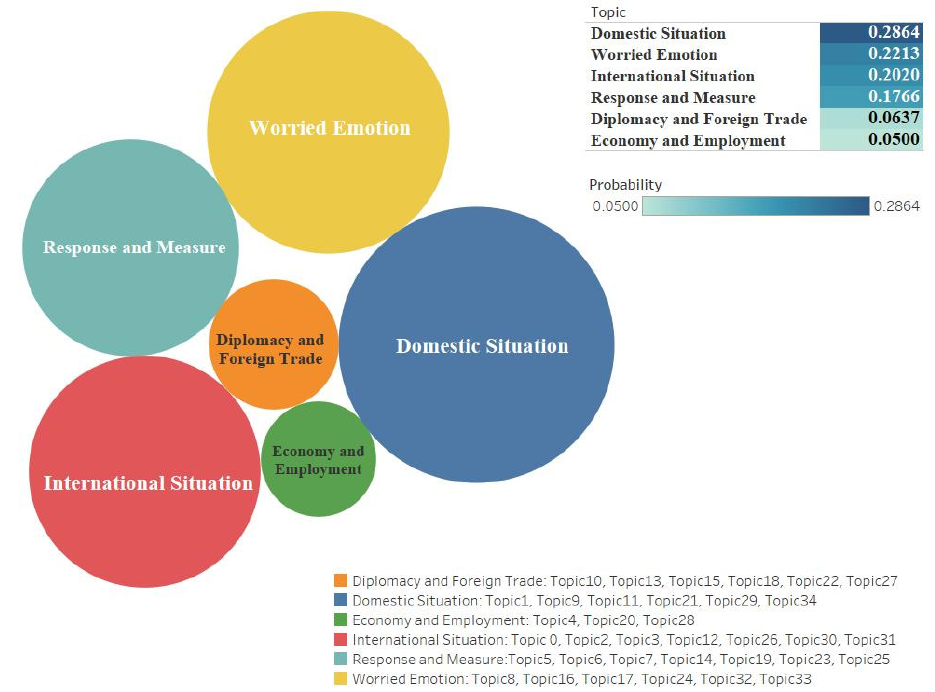
Figure 1. Clustering the topical issues, corresponding topics, and values of Twitter.